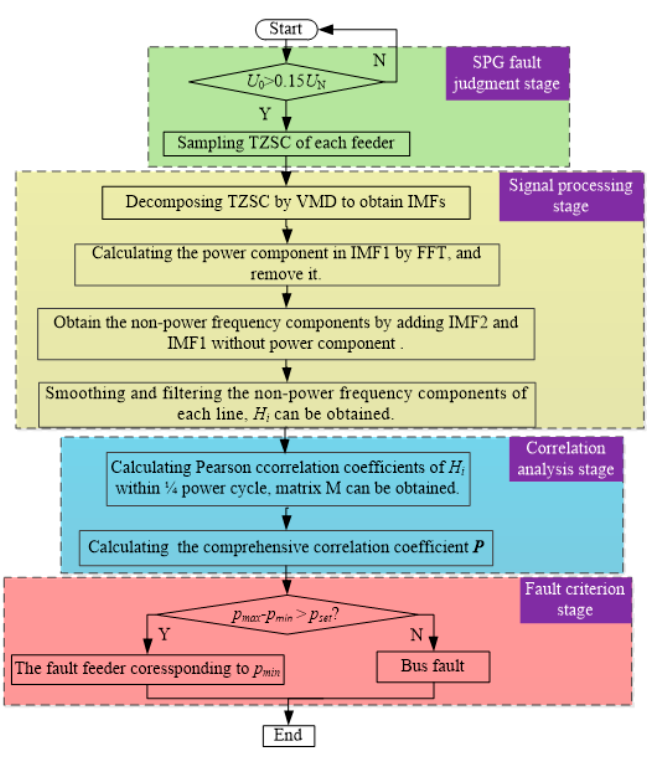
Figure 5. Fault detection flow chart.